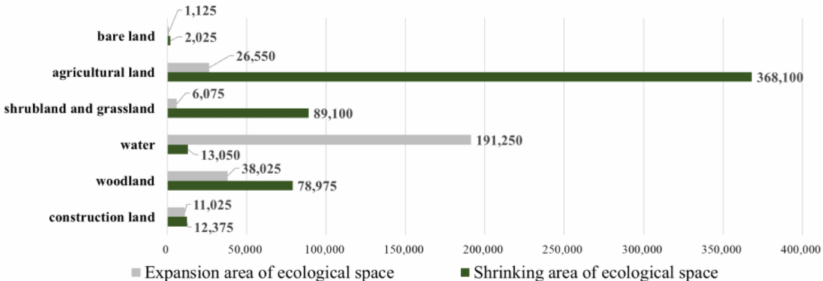
Figure 12. Shrinking and expansion areas of ecological space in land use.